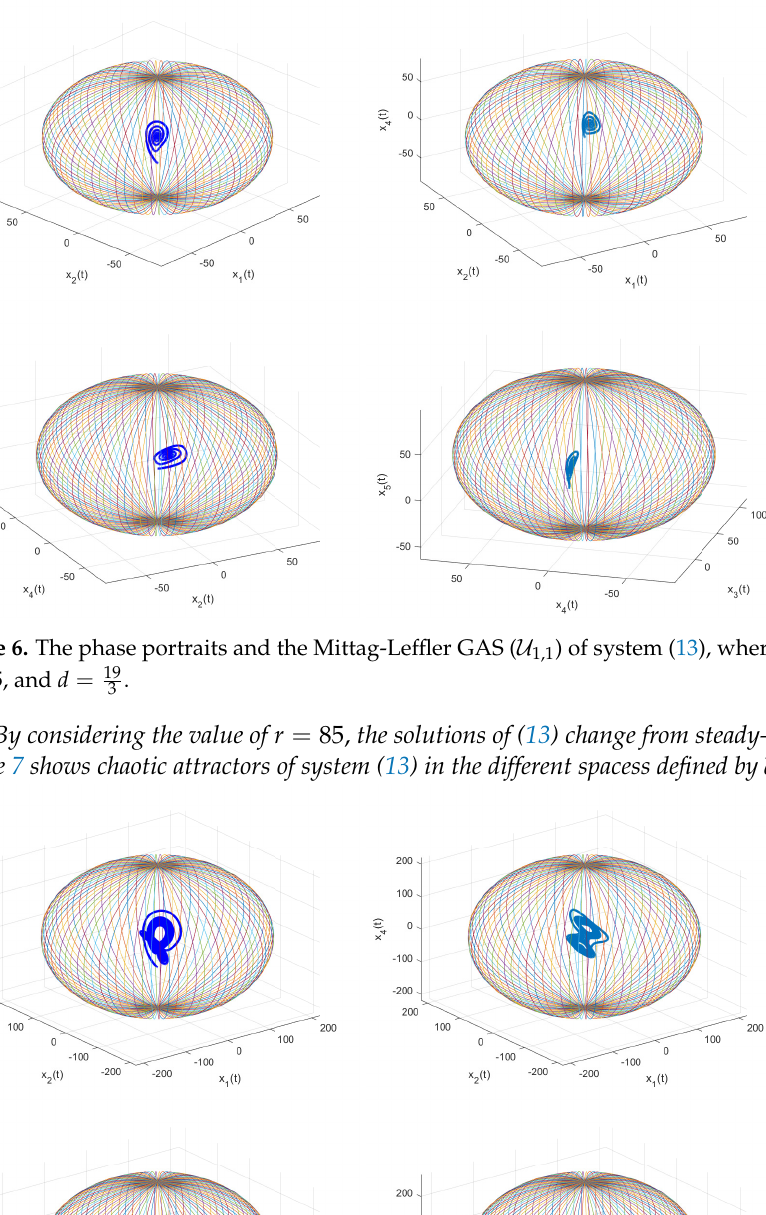
Figure 7. The phase portraits and the Mittag-Leffler GAS of system (13), where σ = 10, b = 8 and d = 19 3